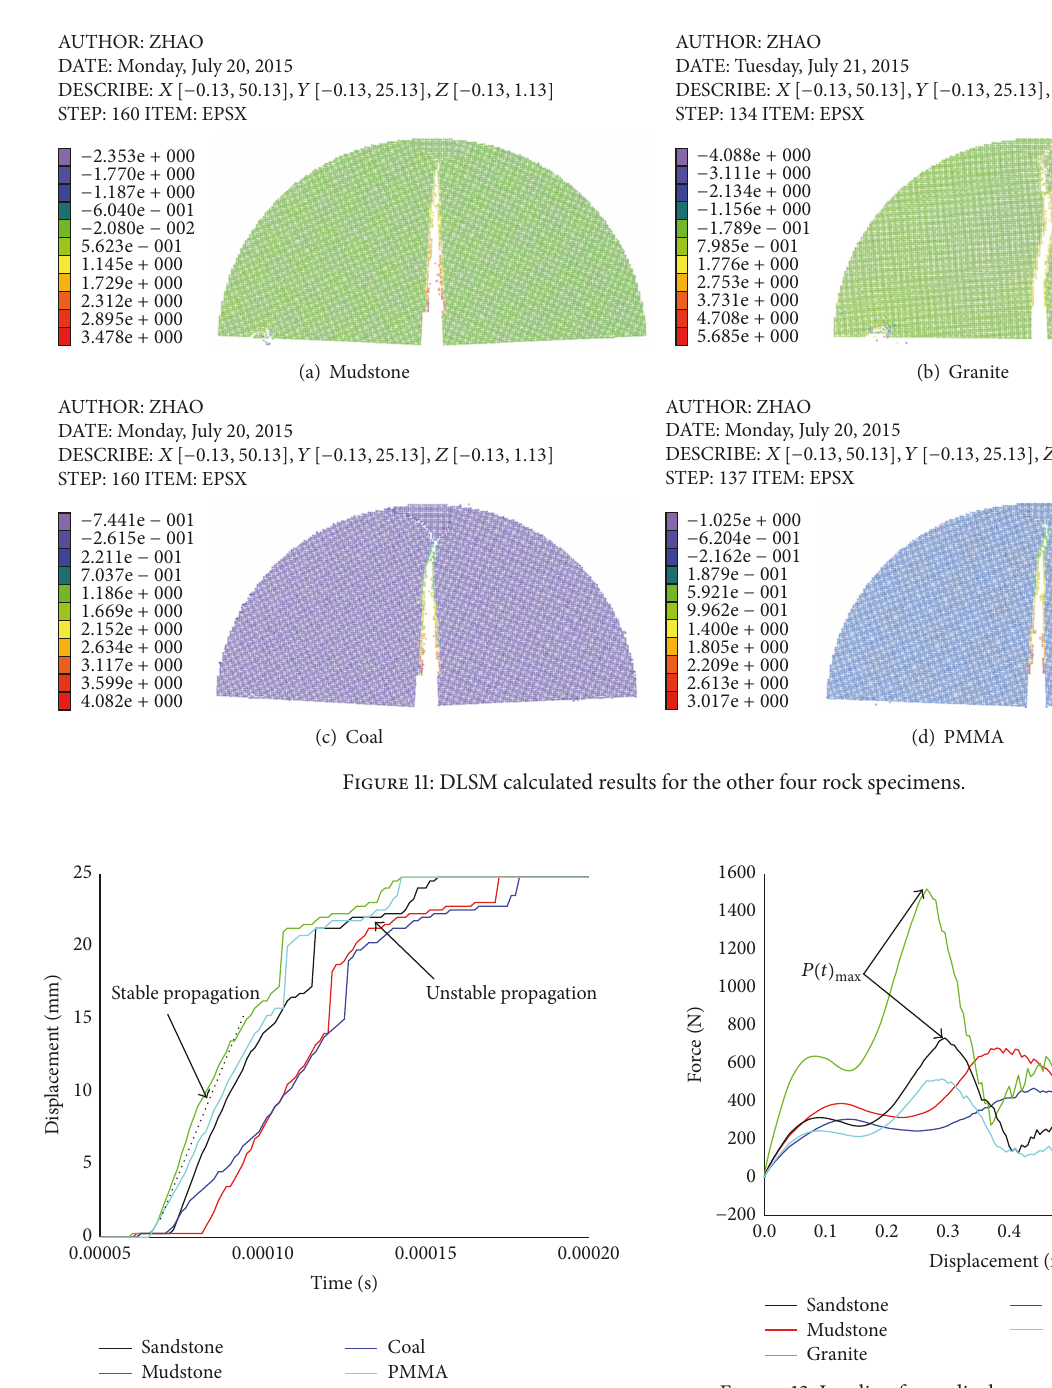
Figure 13: Loading force-displacement curve, V 𝑑 = 4